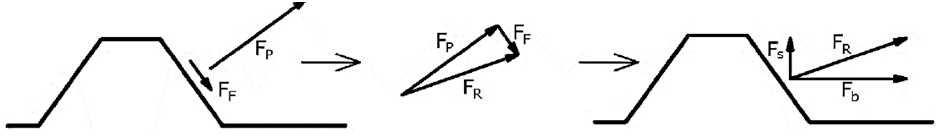
Figure 1. Forces on the bar rib (description in text).